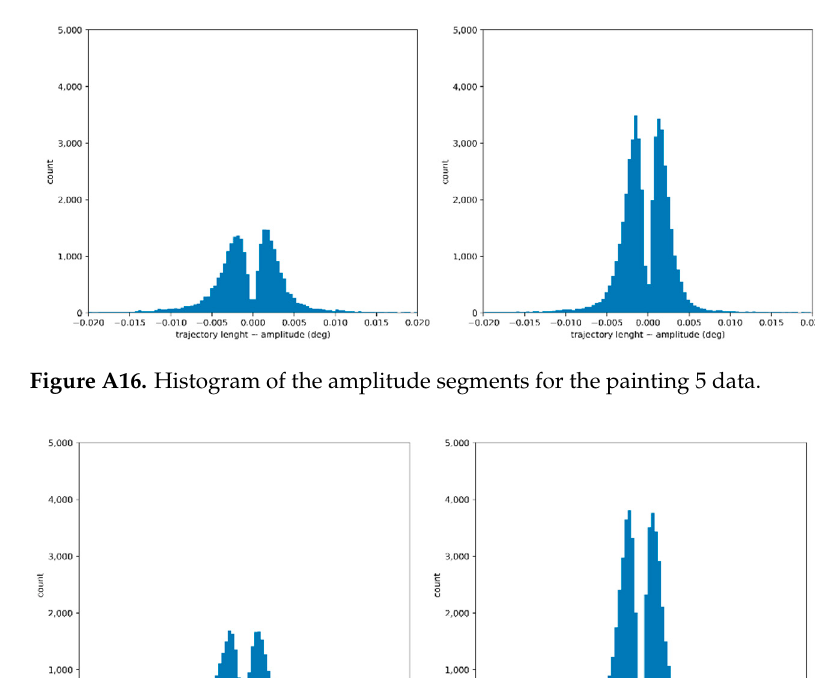
Figure A18. Histogram of the amplitude segments for the painting 7 dataset. Appendix E Table A1. Support vector machine scores for AIDEAL based data sets. Dataset